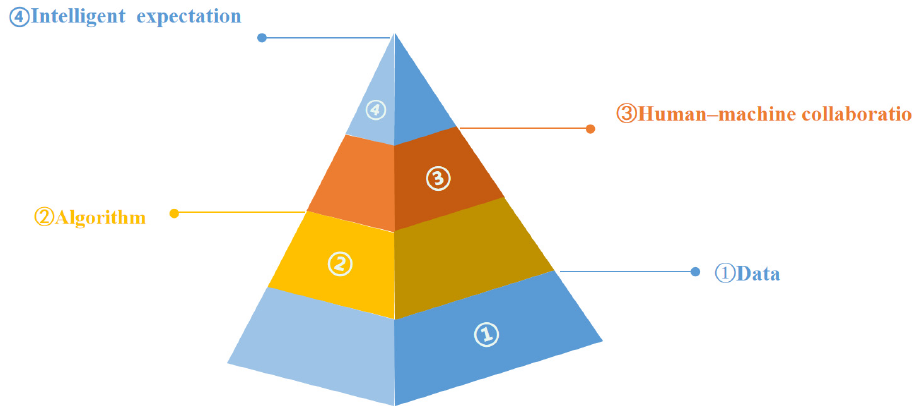
Figure 15. The structure of Intelligent Expectation s.